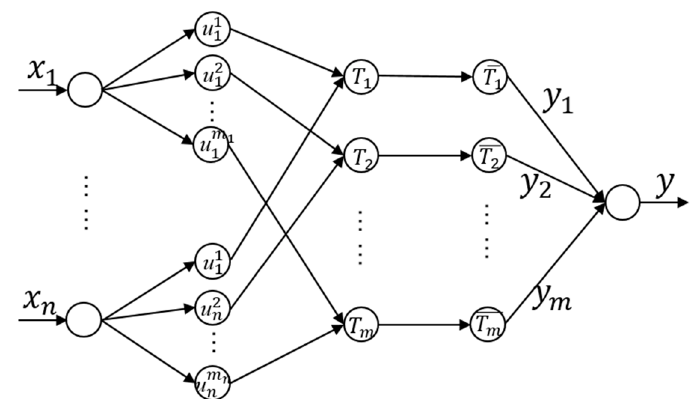
Figure 3. Simplified neural network structure.